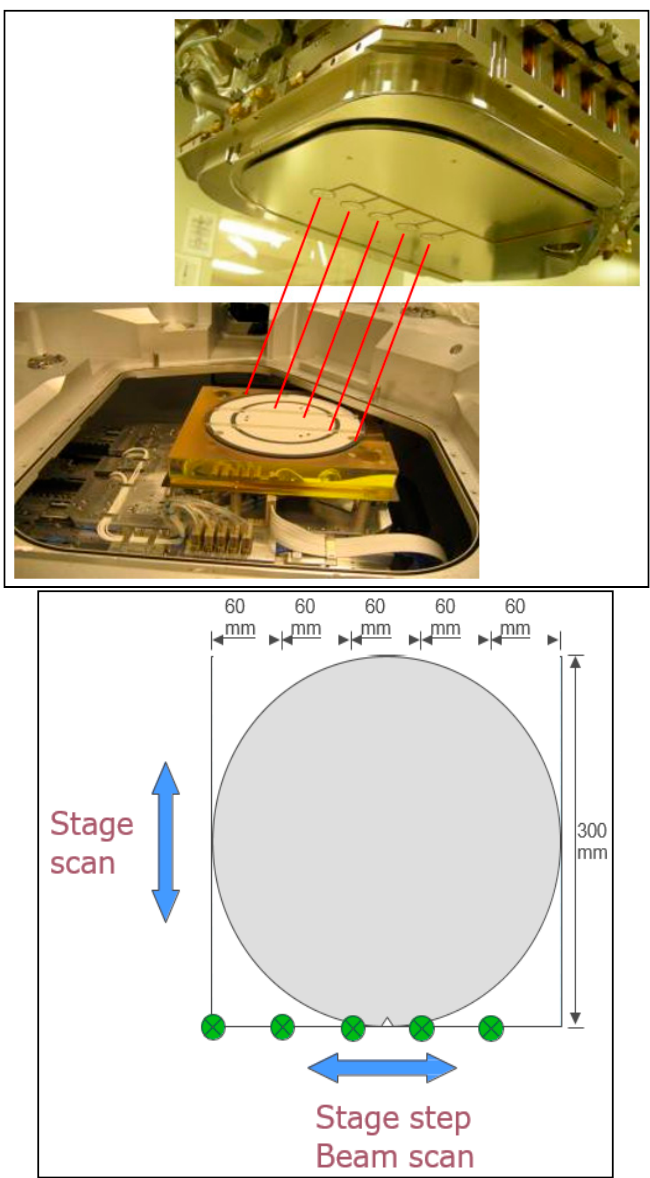
Figure 20. Revolutionary five columns technology to increase the throughput.